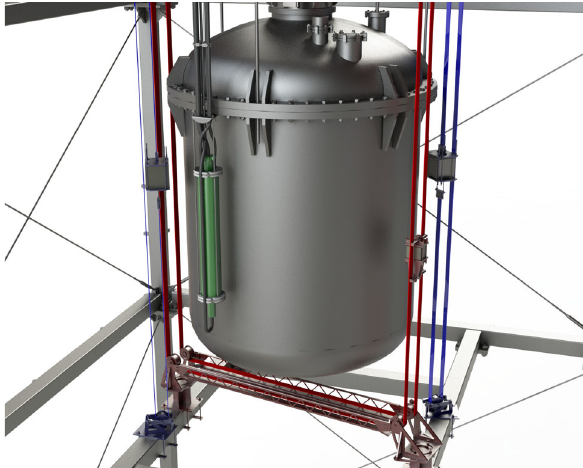
Fig. 12 The deployment system for external calibration sources. Two belts (“I-belts”, blue) allow for vertical movement of sources inside their W-collimators, while one belt (“U-belt”, red) reaches areas around the detector bottom. The DD-fusion neutron generator (green) can be vertically displaced along the cryostat